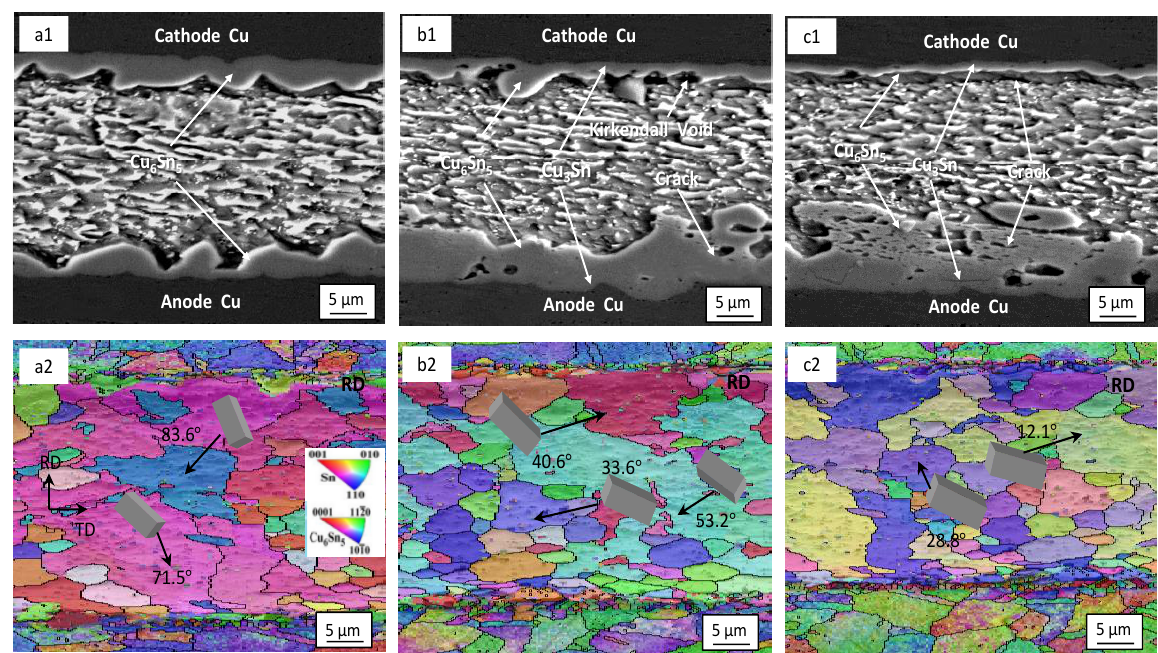
Figure 4. Microstructure and EBSD orientation of solder joints at different current densities for 200 h of loading: ( a1 , b1 , c1 ) microstructure at 4 × 10 3 A/cm 2 , 7 × 10 3 A/cm 2 , and 1 × 10 4 A/cm 2 ; ( a2 , b2 , c2 ) crystal structure.